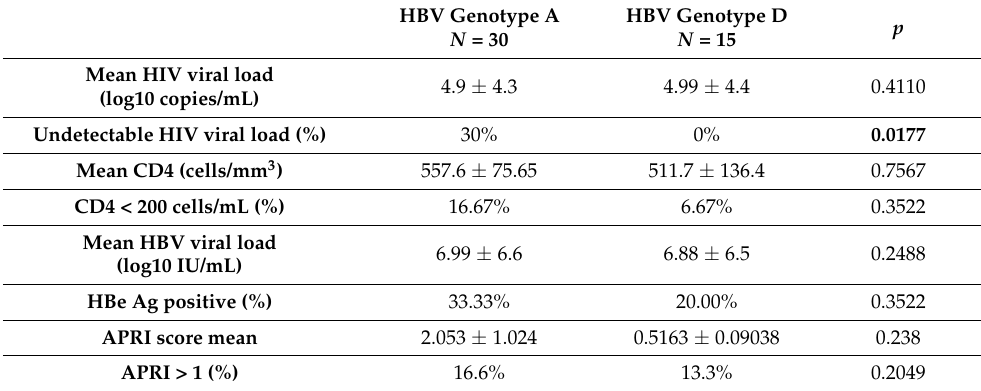
Table 2. Patients’ characteristics by HBV infecting